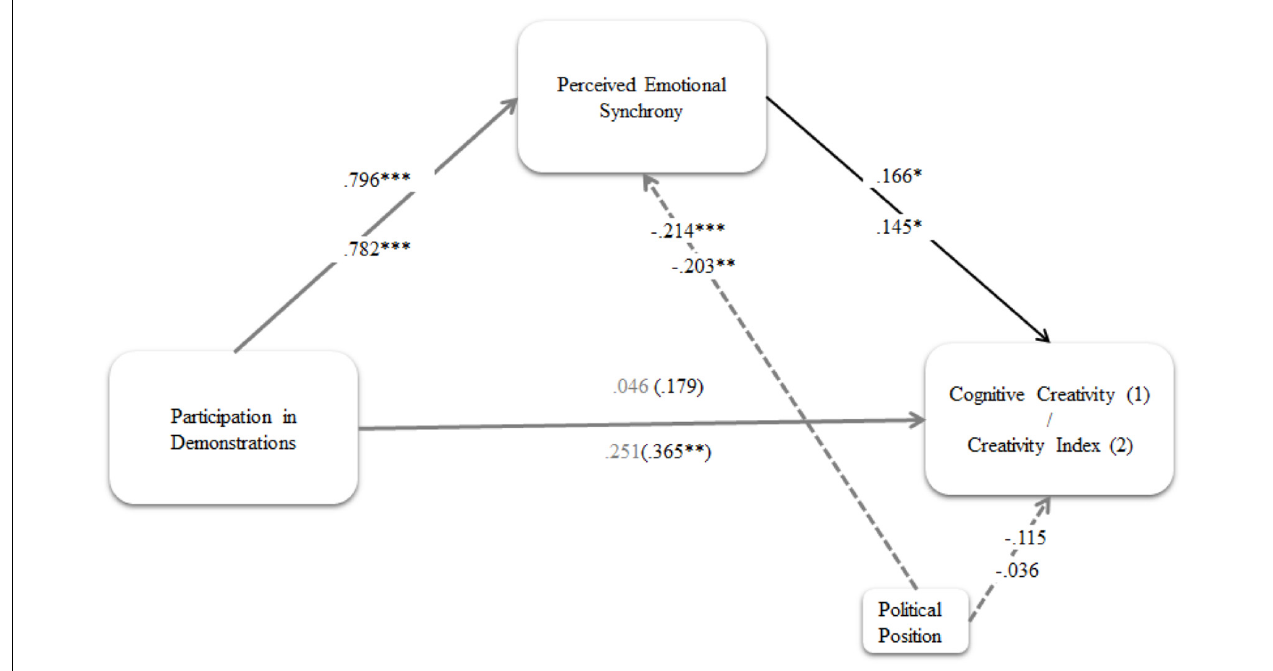
FIGURE 4 | Mediation models H3b: Cognitive Creativity (1) and Creativity Index (2). Standardized indirect effect on: Cognitive Creativity: 0.132 (0.066) [0.013;0.273] on Creativity Index 0.113 (0.058) [0.010;0.240]. Coefficients in the upper side refers to cognitive creativity and in the lower part to creativity index. Standardized regression coefficients are presented. Numbers in parentheses refer to total effect. ∗ p < 0.05, ∗∗ p < 0.01, ∗∗∗ p <